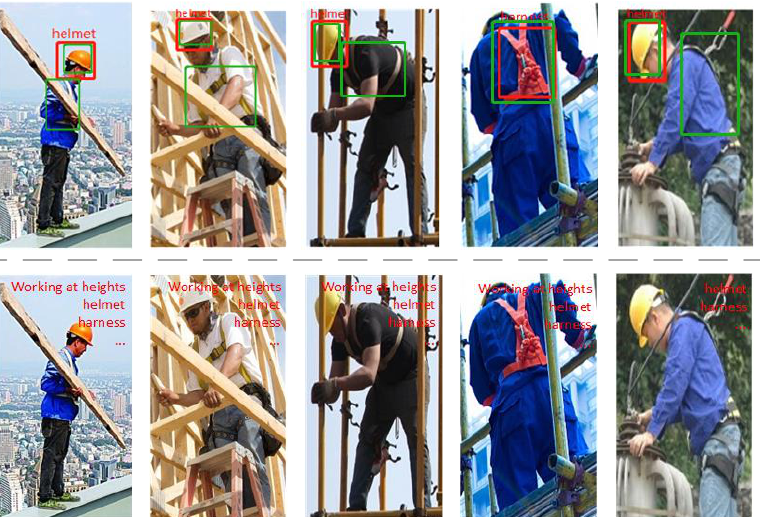
Figure 13. The difference between the object detection model and the attribute recognition model. The top row is the processing results of the general object detection models (YOLOv5), and the bottom row is the processing results of our proposed attribute recognition model (ours). In object detection, green bounding boxes represent ground truth, and red boxes represent predicted results. In attribute recognition, the result of the recognition is displayed directly on the image in the form of text.